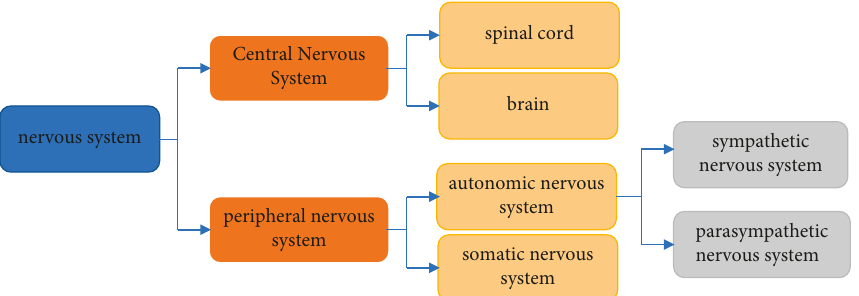
Figure 5: Hierarchical structure of the